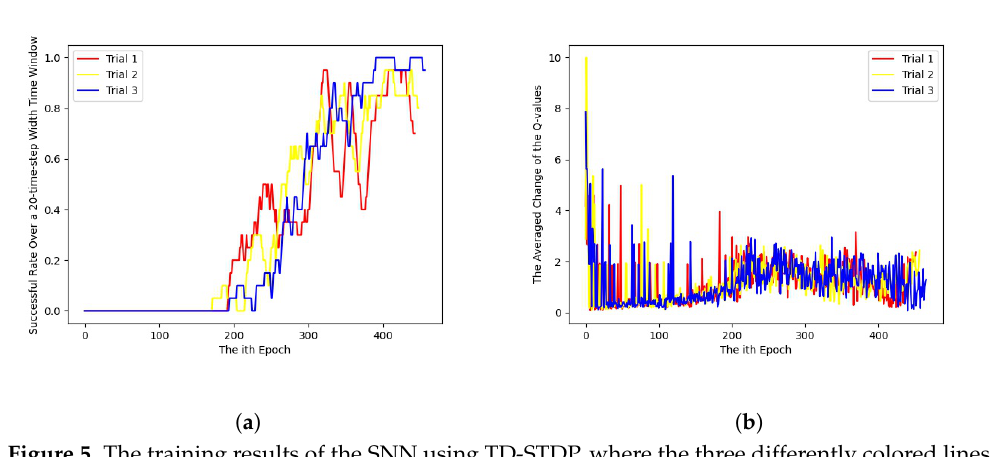
Figure 5. The training results of the SNN using TD-STDP, where the three differently colored lines indicate the three independent trials: ( a ) the success rate of the SNN controller changes over the training epochs using TD-STDP learning; ( b ) the root mean square change of the SNN-produced Q values between two consecutive training epochs during TD-STDP training. In this and the subsequent figures, different colors indicate independent training